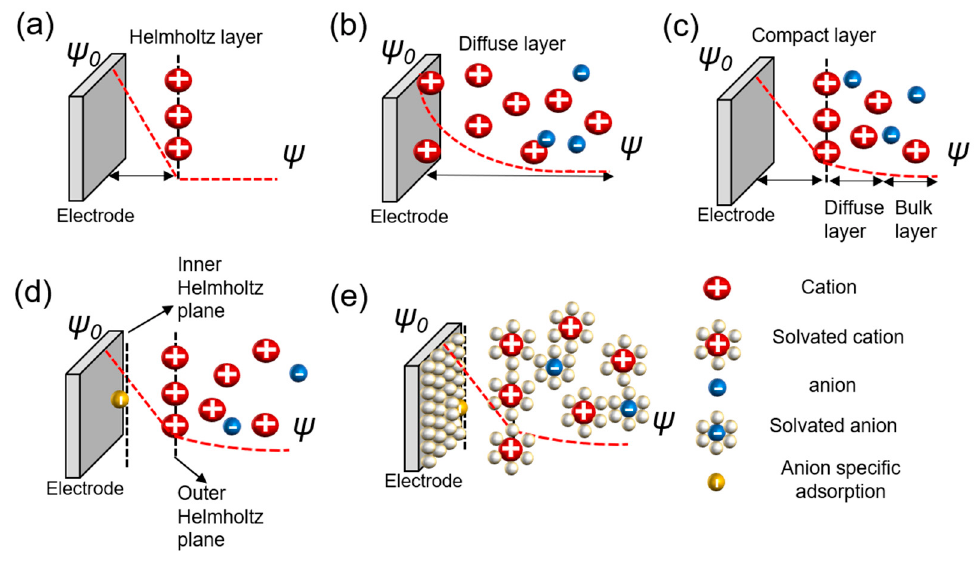
Figure 2. Models of the electrochemical double layer. ( a ) Helmholtz model; ( b ) Gouy–Chapman or diffuse model; ( c ) Stern model; ( d ) Grahame model; ( e ) Bockris, Devanathan, and Muller model [25–27] .